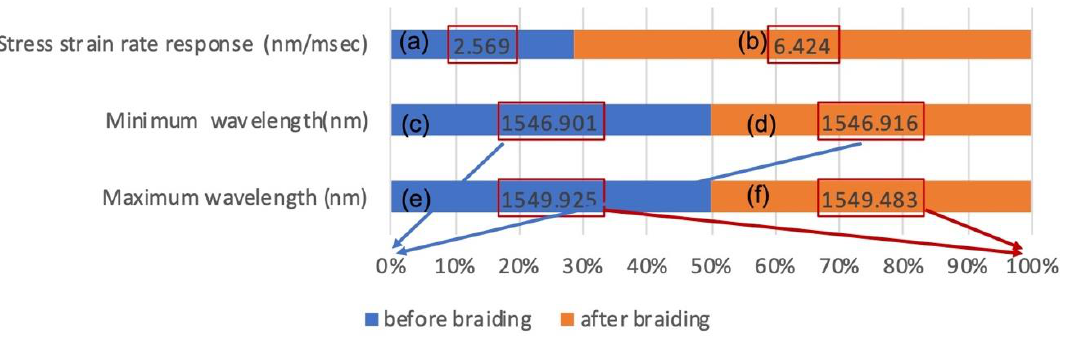
Figure 11. Comparison of the stress–strain response of the optical waveguide axis before and after braiding ( a , b ). The fast rate of responsiveness to stress–strain. ( c , d ) The stress–strain response minimum (0%) before and after braiding on the optical waveguide axis. Before and after the stress–strain response, maxima (100%) were compared ( e , f ).